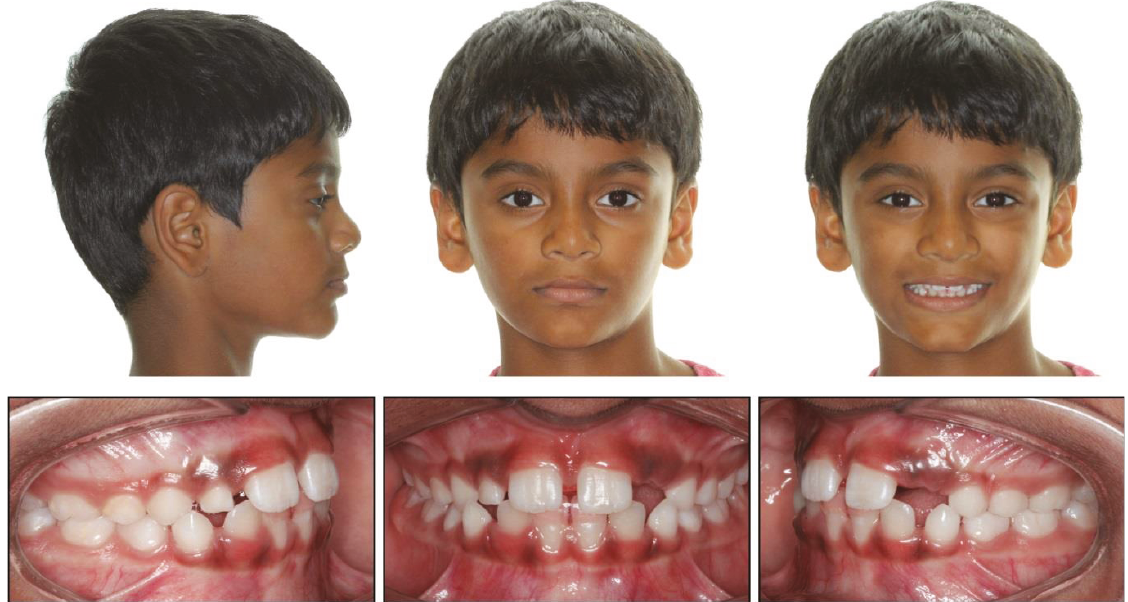
Figure 7: Posttreatment composite at the following visit after 3